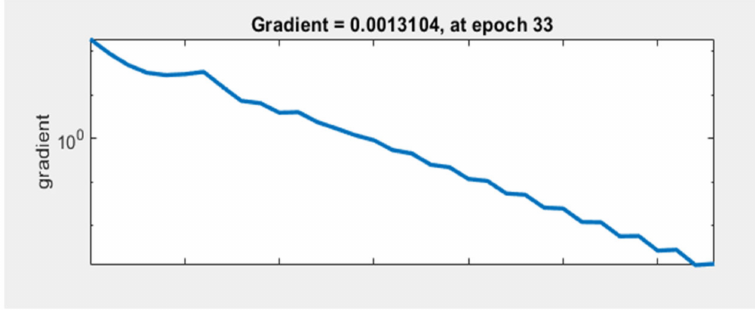
Figure 12. Neural network train state